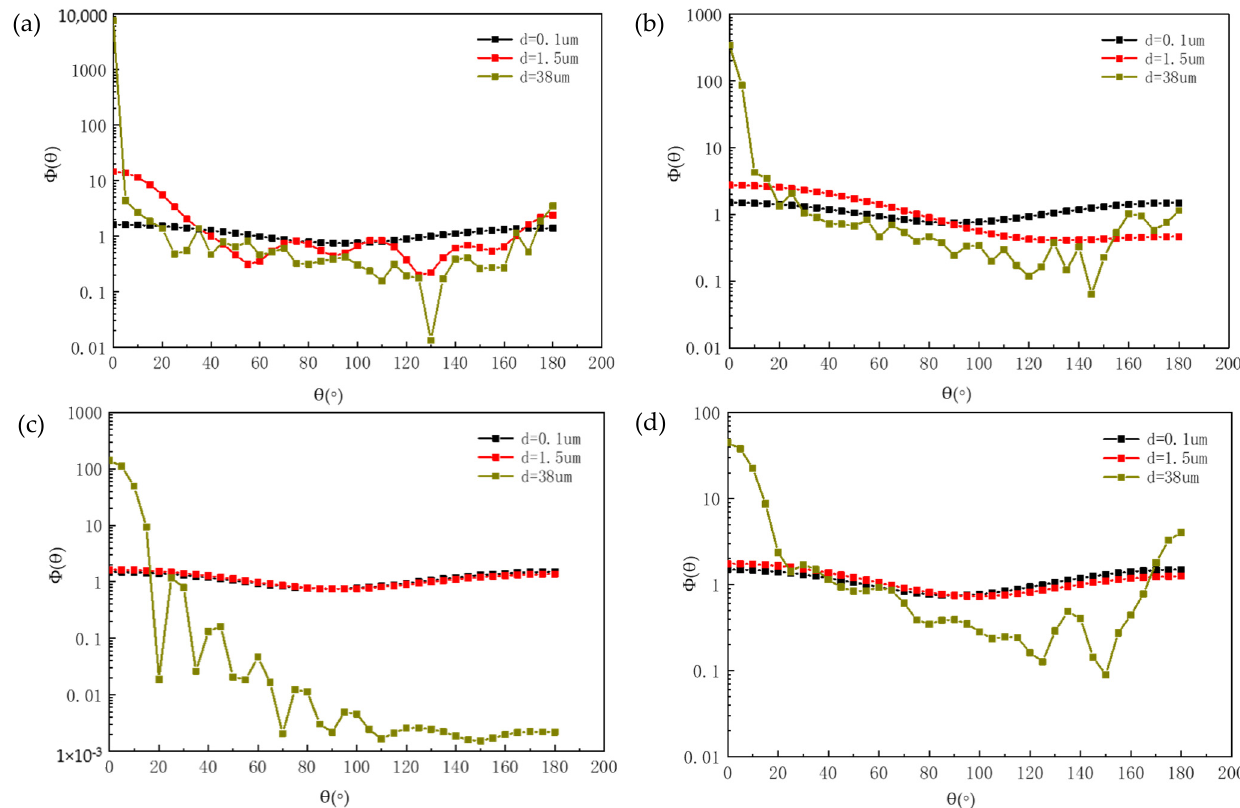
Figure 3. The scattering phase functions of SiC particles changing with different particle sizes: ( a ) λ = 1; ( b ) λ = 4.9999; ( c ) λ = 10.009; ( d ) λ = 14.985 μ m.